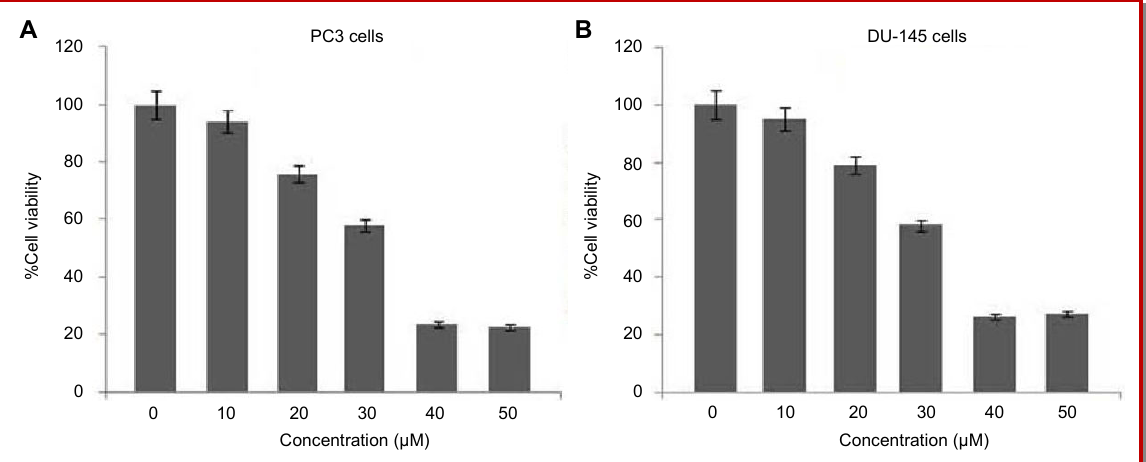
Figure 1 : Effect of BHP on inhibition of proliferation in PC3 and DU-145 cells. The viability of the cells was determined by MTT assay. BHP caused significant reduction in the viability of PC3 and DU-145 cell lines